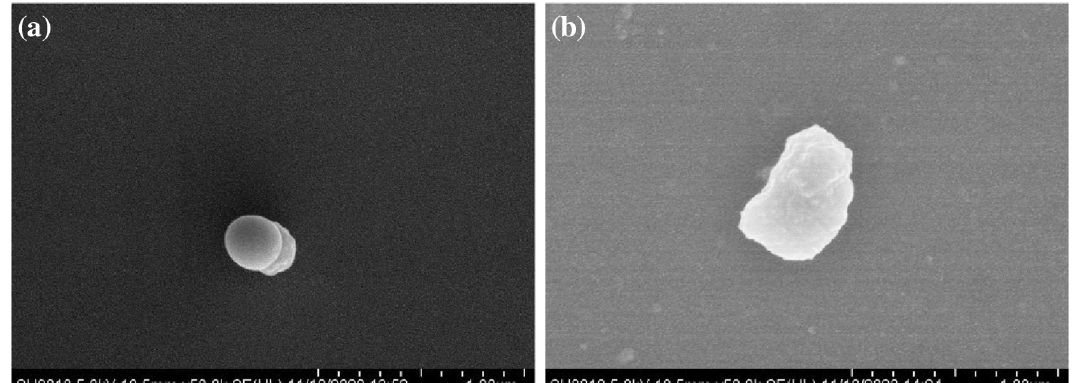
Figure 6. Scanning electron microscope images of Si preparation. ( a ) shows Si-50G. ( b ) shows